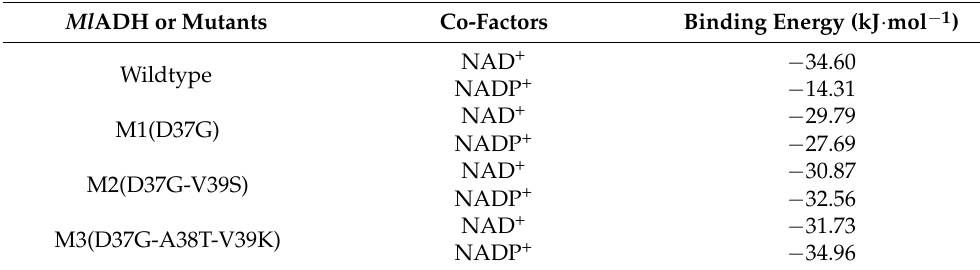
Figure 4. Intramolecular interactions and enzyme surface structure analysis of the wildtype Ml ADH complexed with NAD + and its mutants of M1 and M3 complexed with NADP + . The dotted lines represent hydrogen bonds. Table 3. Docking and binding energy of Ml ADH and its mutants to NAD(P) + .